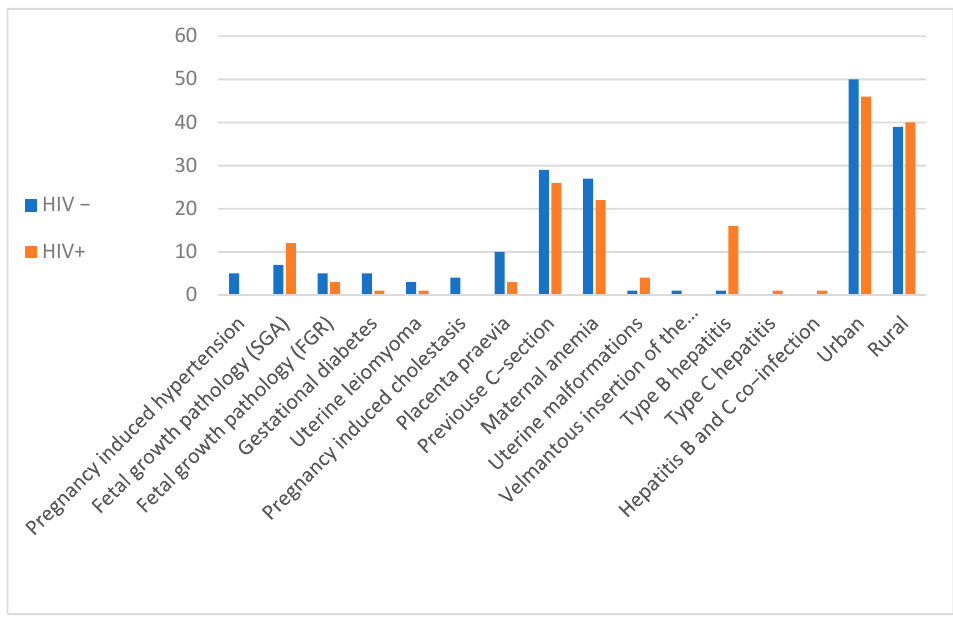
Figure 1. Distribution of cases by demographics and associated pathologies .